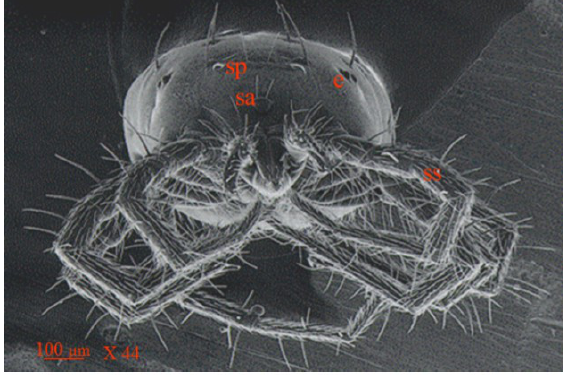
Figure 6. Scanning electron micrograph showing anterior view of Anystis baccarum . Legs densely covered in short smooth setae (ss); anterior margin of idiosoma bearing sensilla (sa); prodorsal shield bearing pair of sensilla (sp); eyes located postero-lateral to prodorsal shield (e) (Photo: Andrew G. S. Cuthbertson © ).